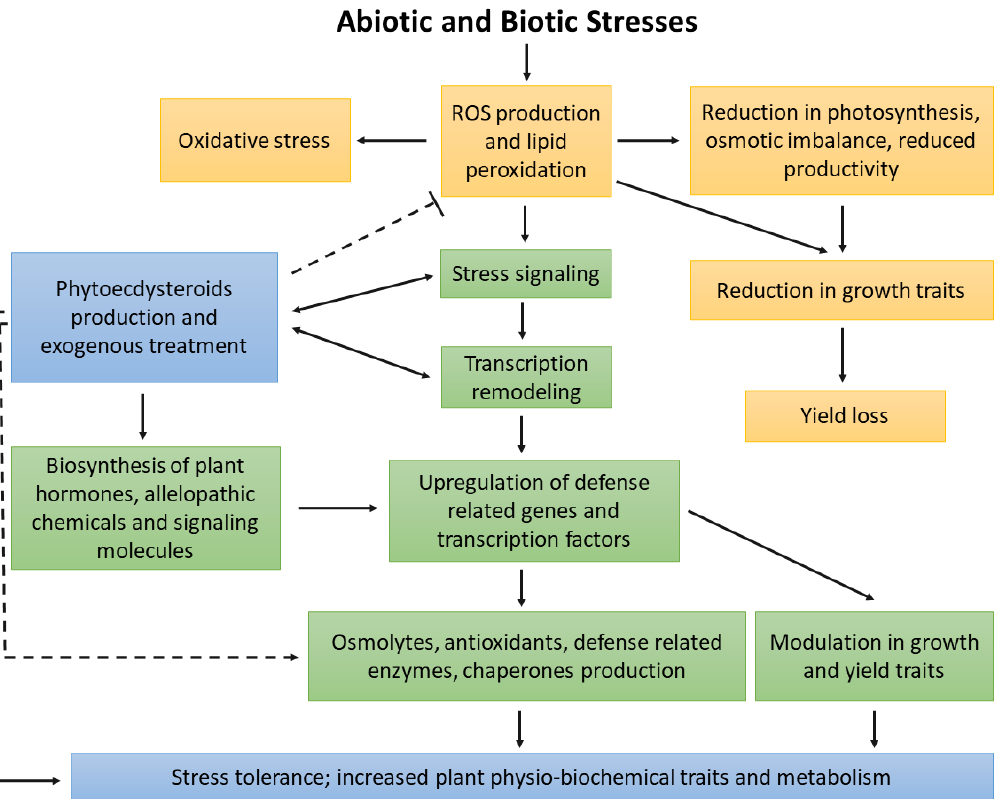
Figure 5. Phytoecdysteroid’s mechanistic approach to enhancing plant stress tolerance.